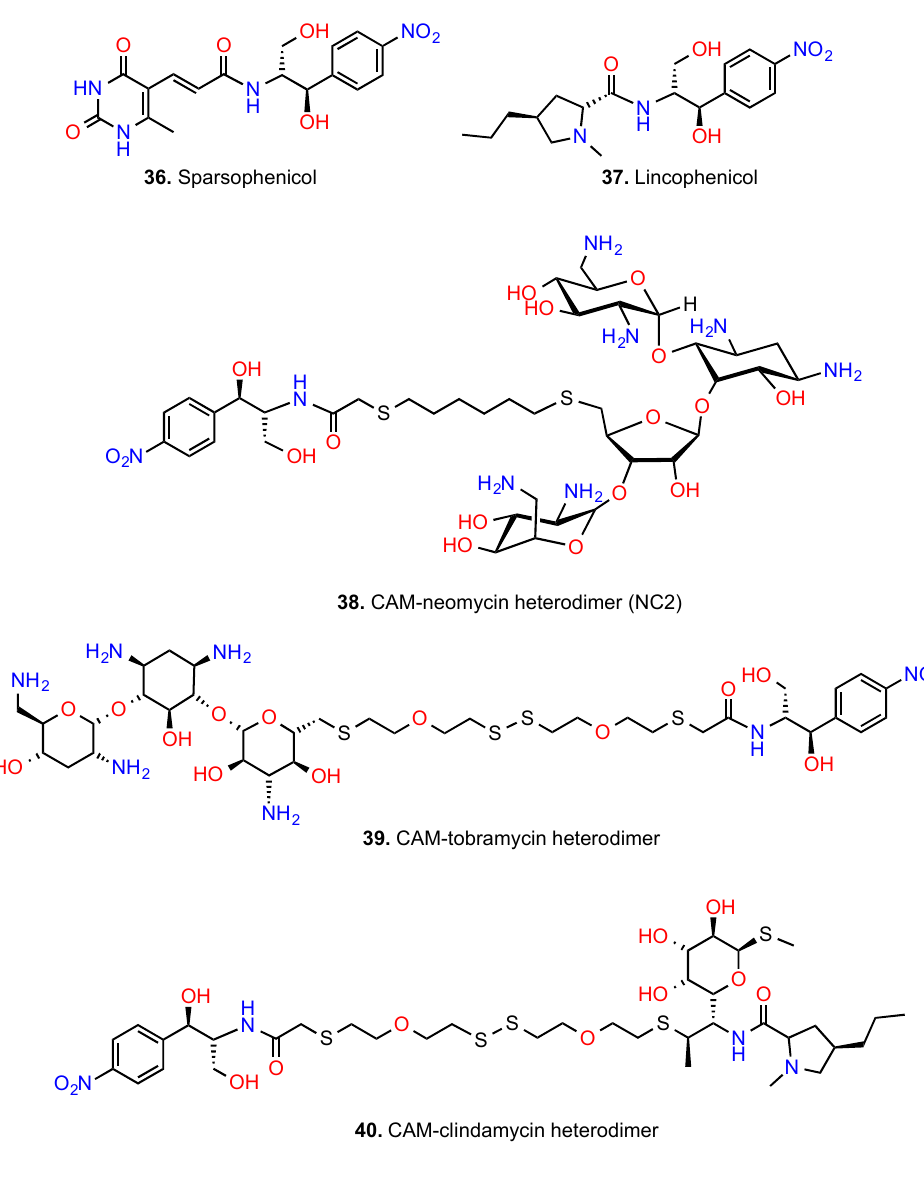
Figure 11. CAM hybrids and heterodimers.